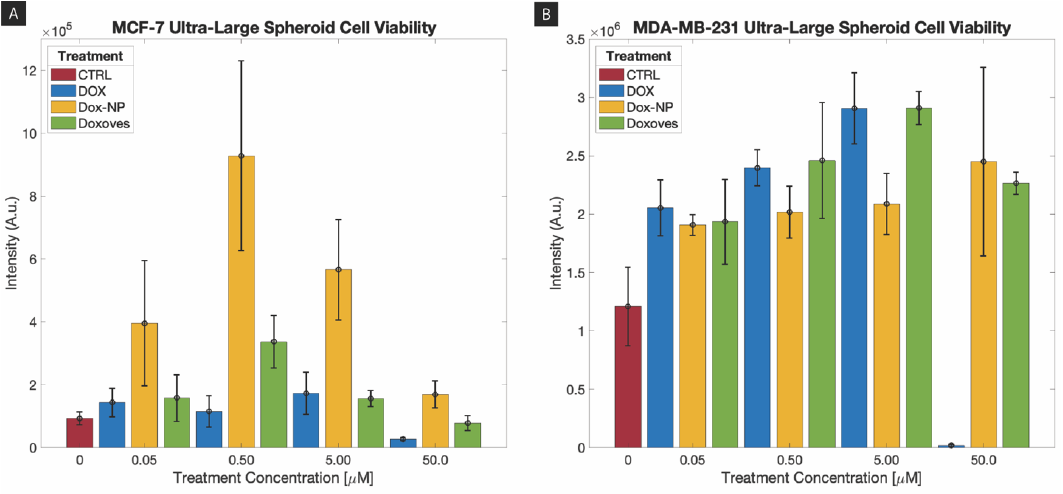
Figure 6. ATP luminescence readings of ( A ) MCF-7 and ( B ) MDA-MB-231 seeded scaffolds exposed molecular DOX, Doxoves TM , and Dox-NP Ⓡ drug formulations at concentrations 0.05 µM, 0.5 µM, 5 µM, and 50 µM versus a control.